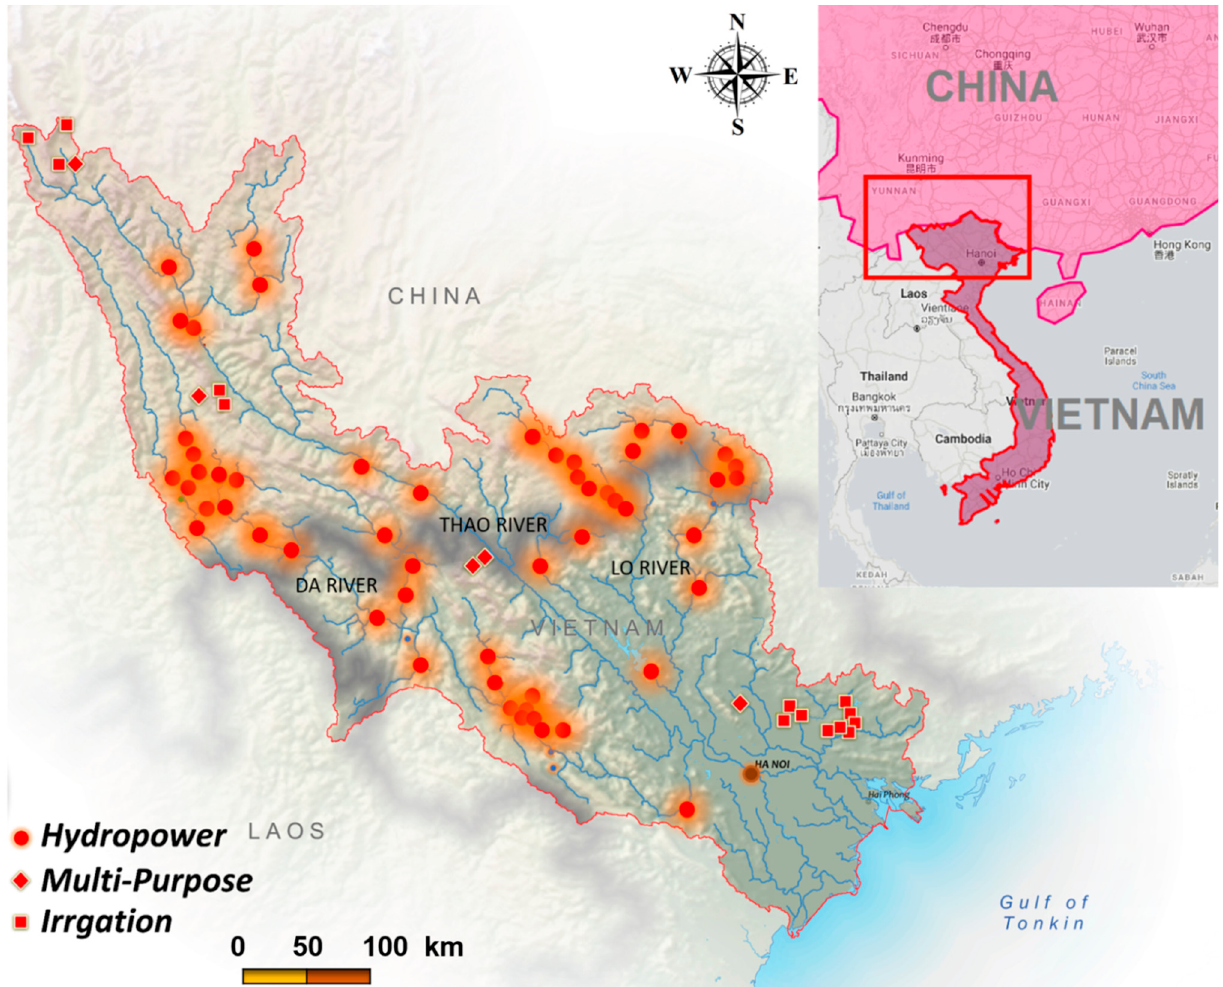
Figure 1. Dams in Red River basin and the Hanoi monitoring site.